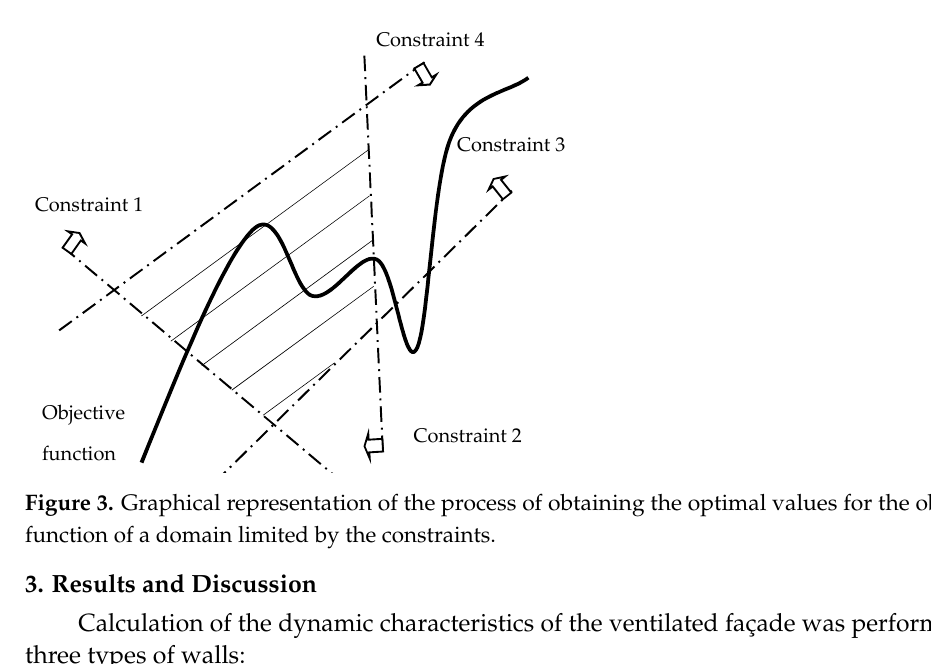
Table 2. External wall of the ventilated façade with the minimum layer